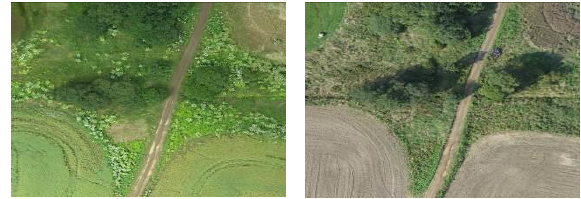
Figure 8 The seasonal variability of the giant hogweed discrimination capabilities from UAV imagery